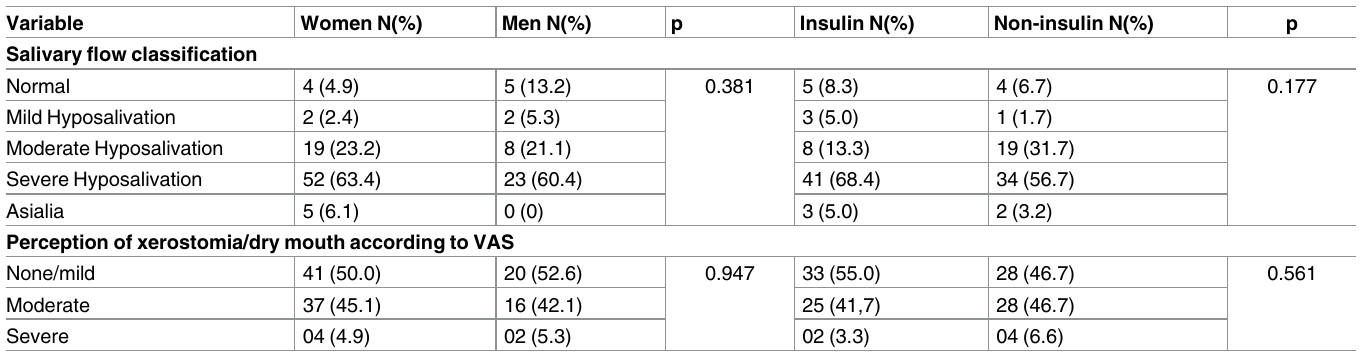
Table 2. Frequency and distribution of salivaryflow classification and perception of xerostomia/dry mouth. Variable